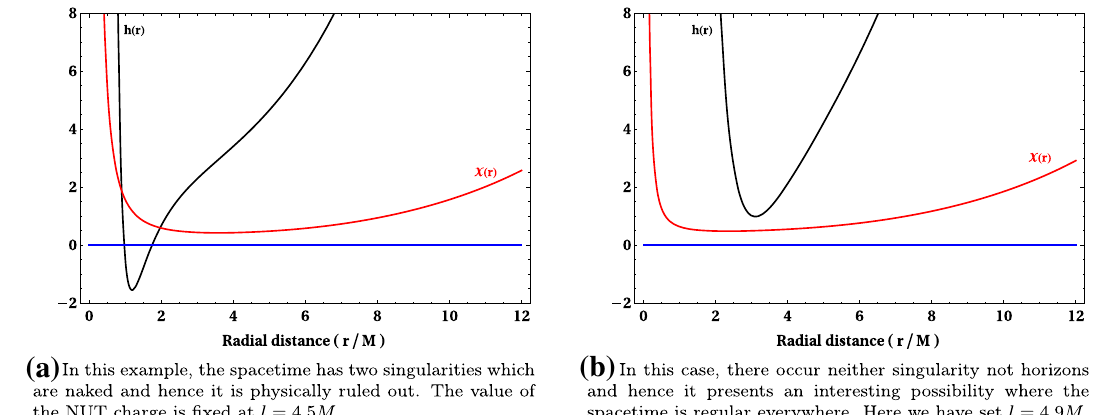
Fig. 4 The above figure illustrate both the possibilities for 24 ≤ λ ≤ 36 where we have set (cid:2) M 4 = 0 . 06